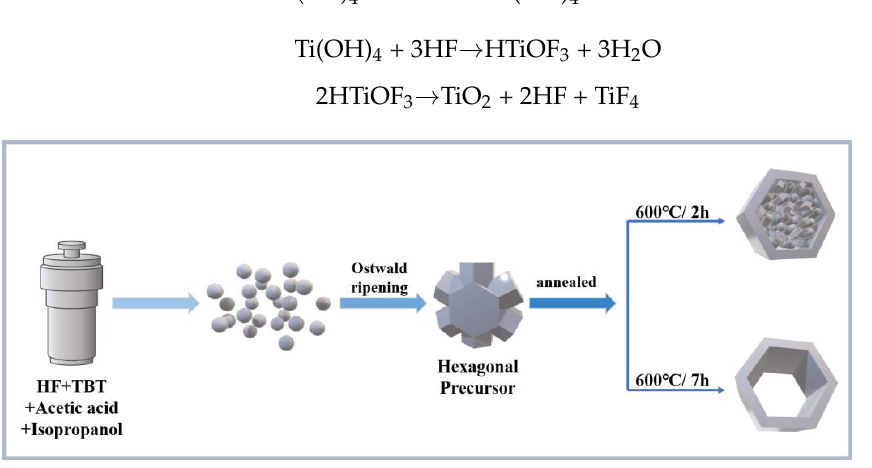
Figure 5. The schematic diagram of TiO 2 with a hexagonal frame structure. Note: 600 °C/2 h, the precursor calcined 600 °C for 2 h; 600 °C/7 h, the precursor calcined 600 °C for 7 h. precursor calcined 600 ◦ C for 2 h; 600 ◦ C/7 h, the precursor calcined 600 ◦ C for 7